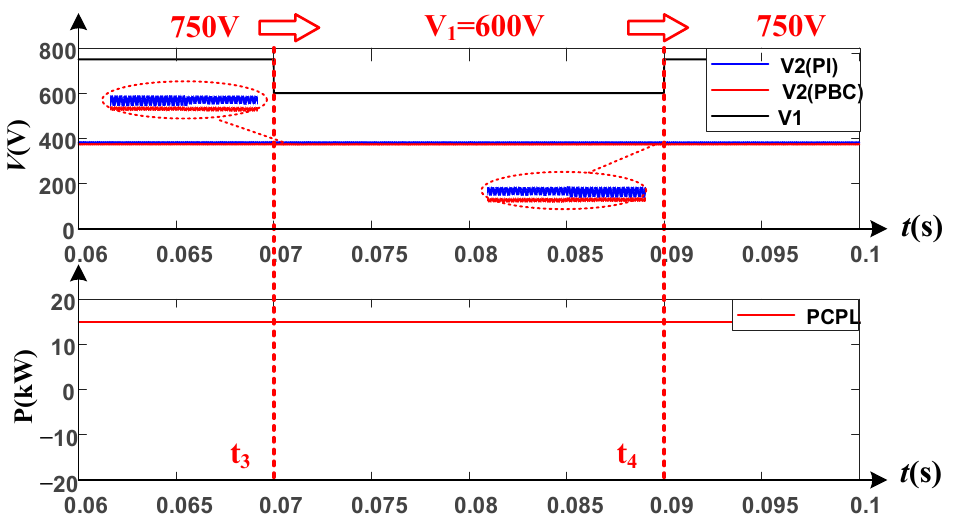
Figure 5. Waveforms in source perturbation simulation.